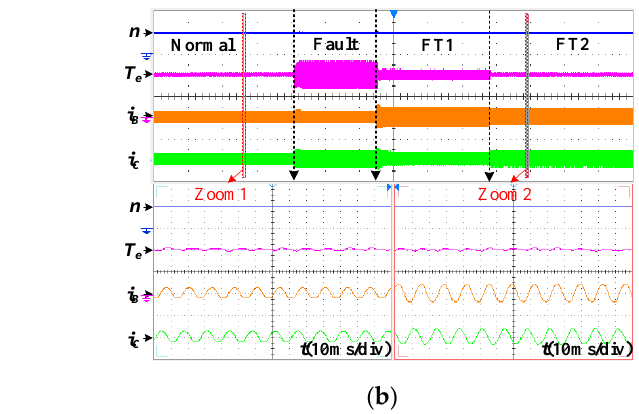
Figure 8. Experimental waveforms under normal operation, fault operation, and phase-A open-circuit fault-tolerant operation. (500 rpm/div, 2 Nm/div, 5 A/div). ( a ) Traditional fault-tolerant FOC. ( b ) Proposed fault-tolerant FOC.